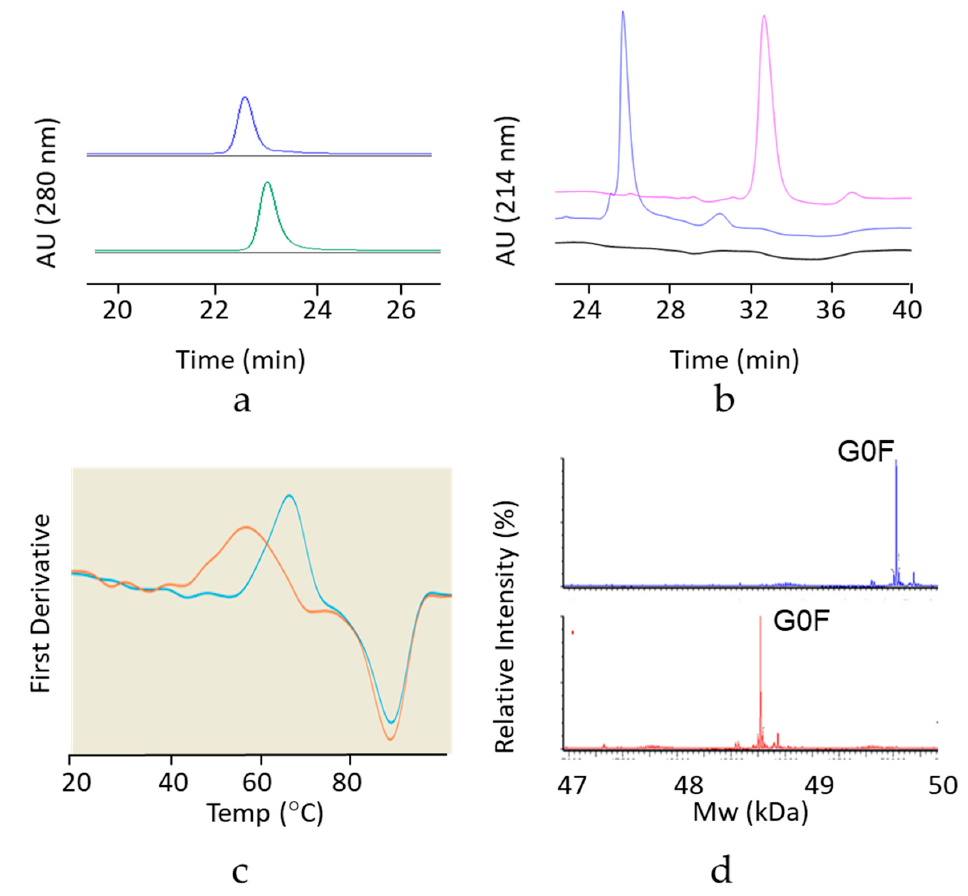
Figure 2. Biochemical and biophysical characterization of the hinge deleted IgG4 and its corresponding full-length control mAb by ( a ) SEC-UPLC coupled to UV (A280) and Multi Angle Laser Light Scattering (MALS). The UV elution profiles of the hinge deleted IgG4 molecule (bottom trace) and the corresponding full-length control (top trace) are shown. MALS data show measured molecular masses of 132 (hinge-deleted) and 149 kDa (full-length mAb). ( b ) Nonreduced CE-SDS coupled to UV (A280). Electropherograms of the buffer control (bottom trace), hinge deleted IgG4 molecule (middle trace) and the corresponding full-length control (top trace) are shown. ( c ) Differential Scanning Fluorimetry. An overlay of the melting profiles of the hinge deleted IgG4 molecule (orange) and the corresponding full-length control (teal) are shown. Melting temperatures/onset were 54.6/47.9 °C (hinge-deleted) and 62.7/56.6 °C (full-length mAb). ( d ) Intact reduced LC–MS. Total Ion Counts of the hinge deleted IgG4 molecule heavy chain (bottom trace) and the corresponding heavy chain of the full-length control (top trace) are shown. The peak corresponding to the dominant Fc N-Glycan G0F species is shown.